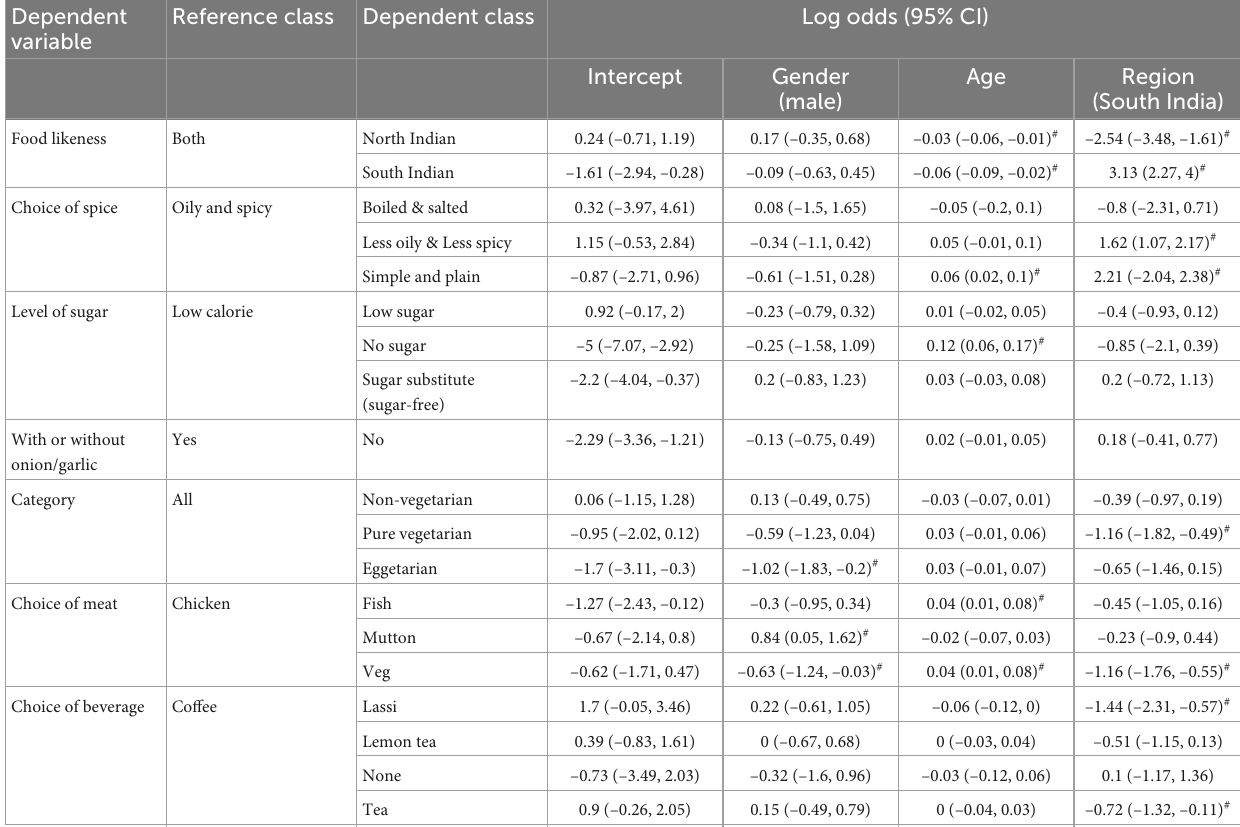
TABLE 2 Log odds values from the multinomial logistic